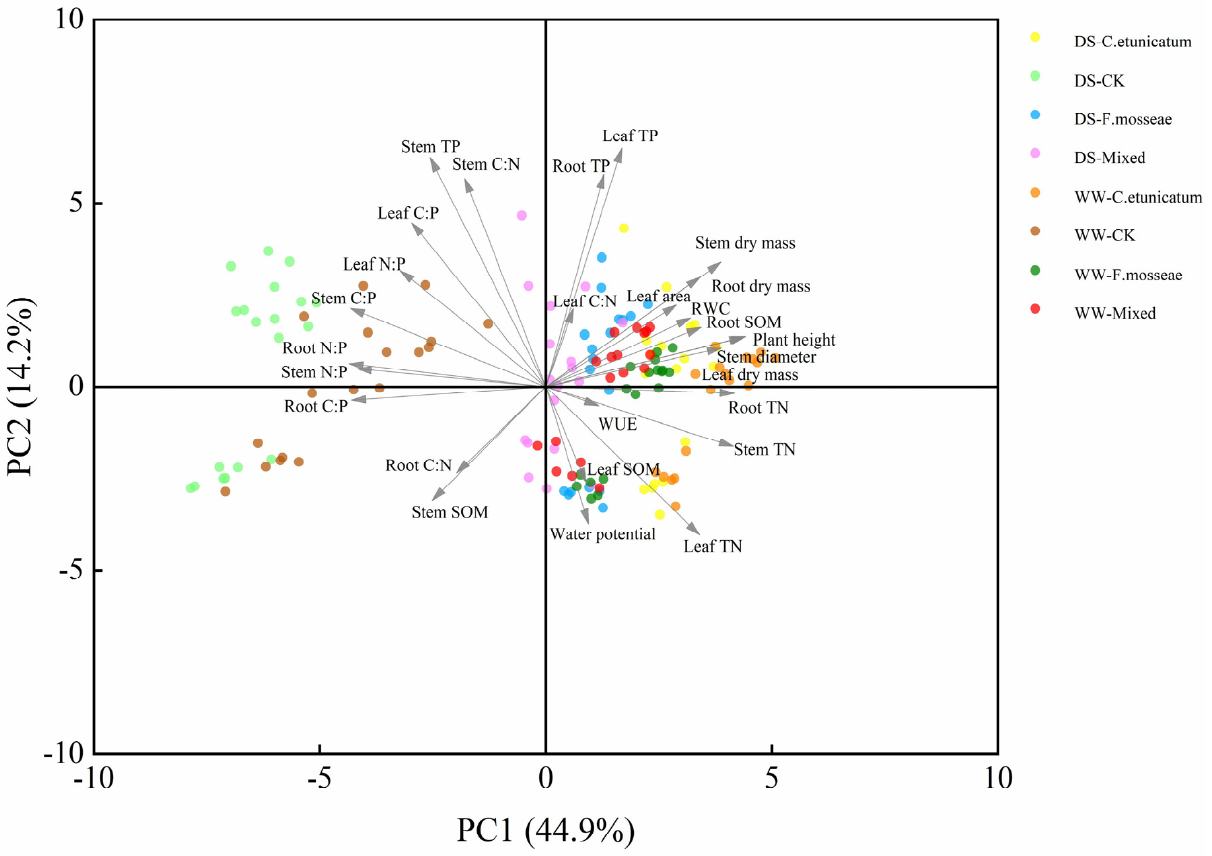
Figure 7. Principal component analysis (PCA) of C. migao inoculated with AMF under drought stress. DS: drought stress; WW: well − watered. C. etunicatum , plants inoculated with C. etunicatum ; F. mosseae, plants inoculated with F. mosseae; Co − inoculation, plants inoculated with F. mosseae and C. etunicatum .